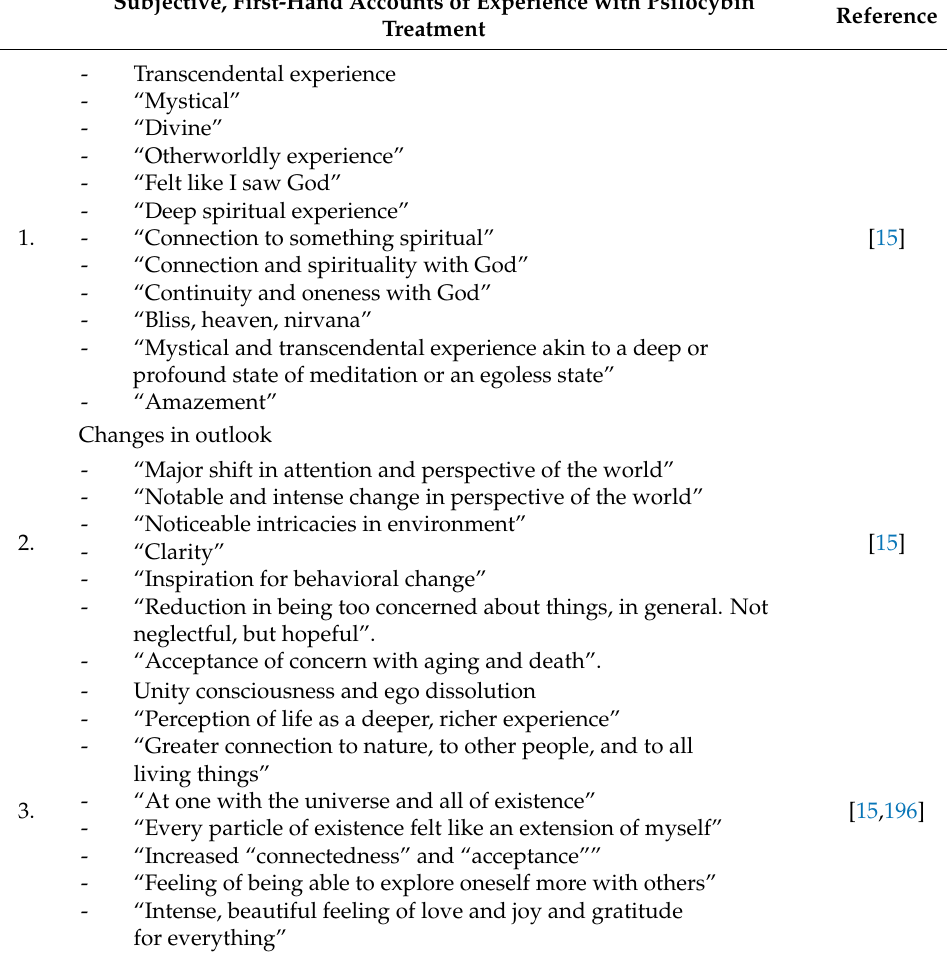
Table 5. A phenomenological study of participant’s experience and subjective perspective during and after psilocybin use report the following first-hand accounts